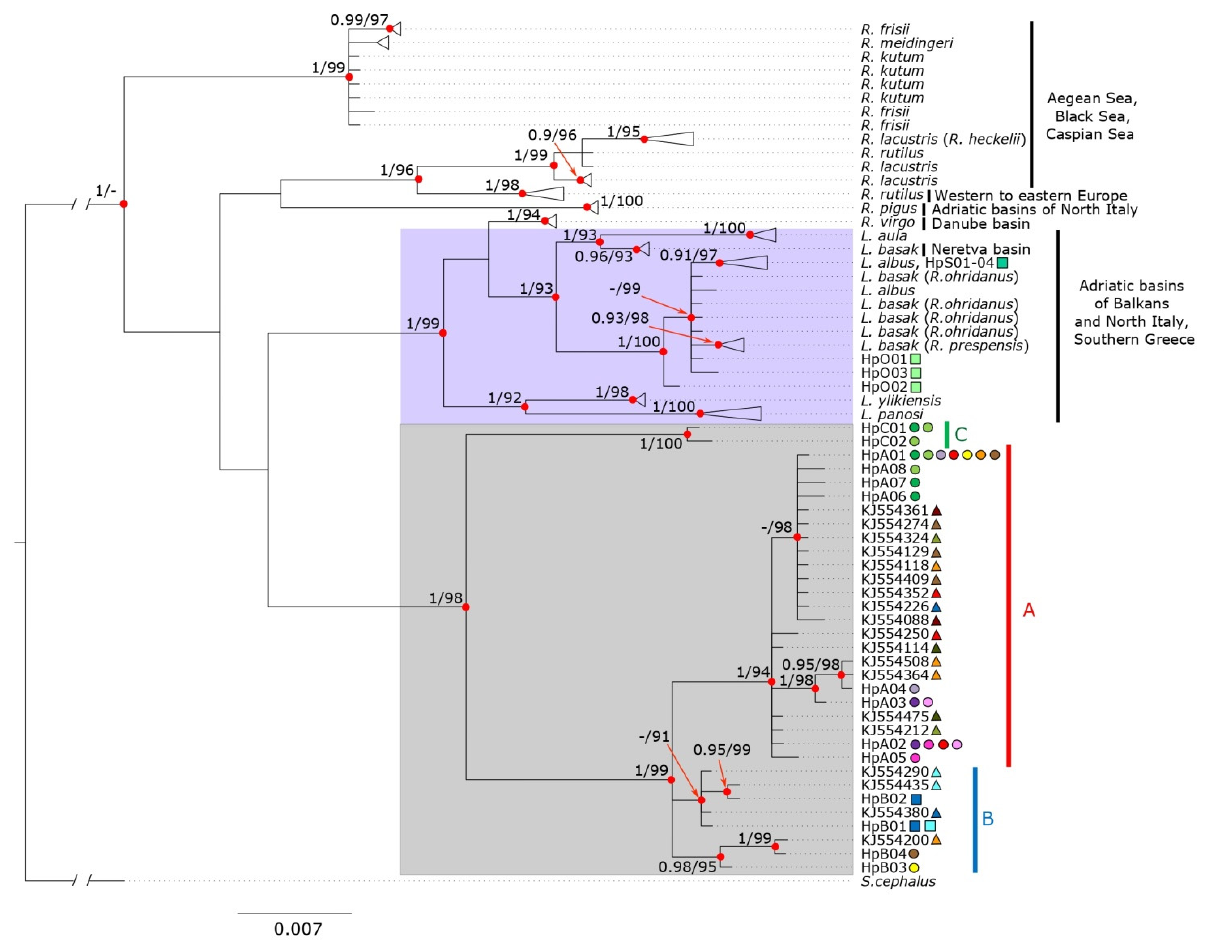
Figure 2. ML and BI phylogenetic tree based on mitochondrial sequences of COI including sequences of all the species originally included in the genus Rutilus (see Table S2 for Accession Number). Haplotypes obtained in this study are indicated and represented by circles (rivers) and squares (lakes); sequences retrieved from Genbank are indicated by triangles. Rectangles on the tree highlight currently recognized Leucos species (violet) and Sarmarutilus (grey); for the latter, three haplogroups are indicated. Posterior probabilities > 0.90 (BI) and bootstrap values > 90 (ML) at each node are